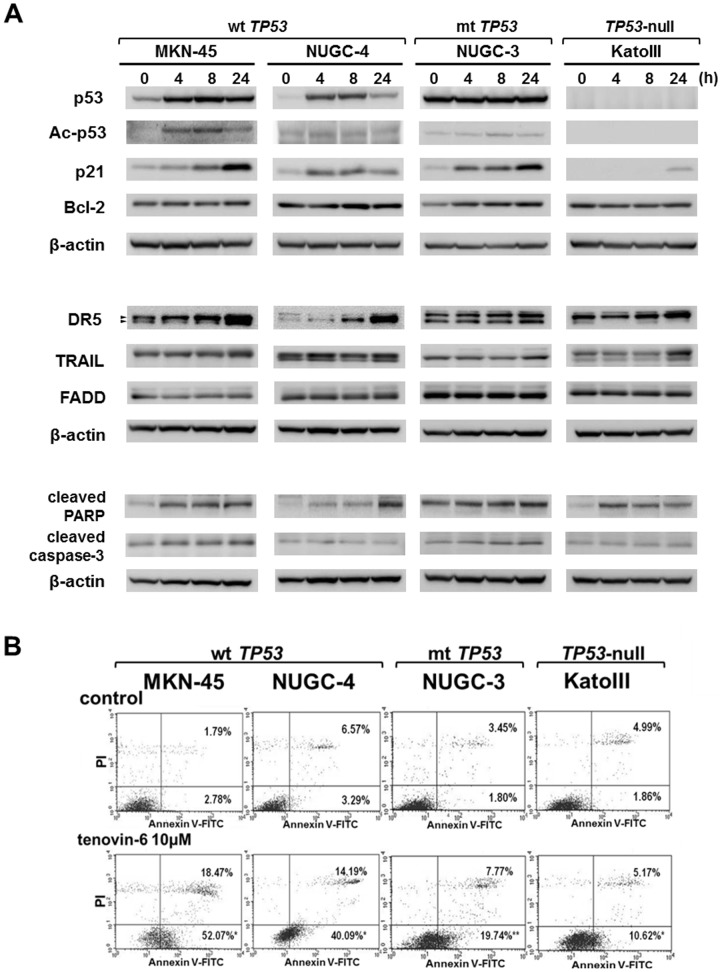
Induction of apoptotic cell death by tenovin-6 in gastric cancer cells.A: Time-course analysis of the expression of p53, its downstream molecule p21Waf/Cip1, and apoptosis-related molecules in gastric cancer cells treated with tenovin-6 (10 µM). Relative intensity of the proteins' expression is shown in Figure S1. Tenovin-6 induced the expression of Ac-p53 and p21Waf/Cip1, but not Bcl-2. DR5 expression was strongly induced by tenovin-6. TRAIL, and cleaved PARP were slightly increased, but FADD expression was not affected. A doublet of DR5 shows its precursor (upper band) and mature isoforms (lower band). B: Four cell lines were treated with tenovin-6 (10 µM) or a vehicle control for 72 h, double-stained with FITC-annexin V and PI, and analyzed by flow cytometry. The statistical significance of differences between groups was evaluated using Student's t-test. * p<0.01; ** p<0.05.